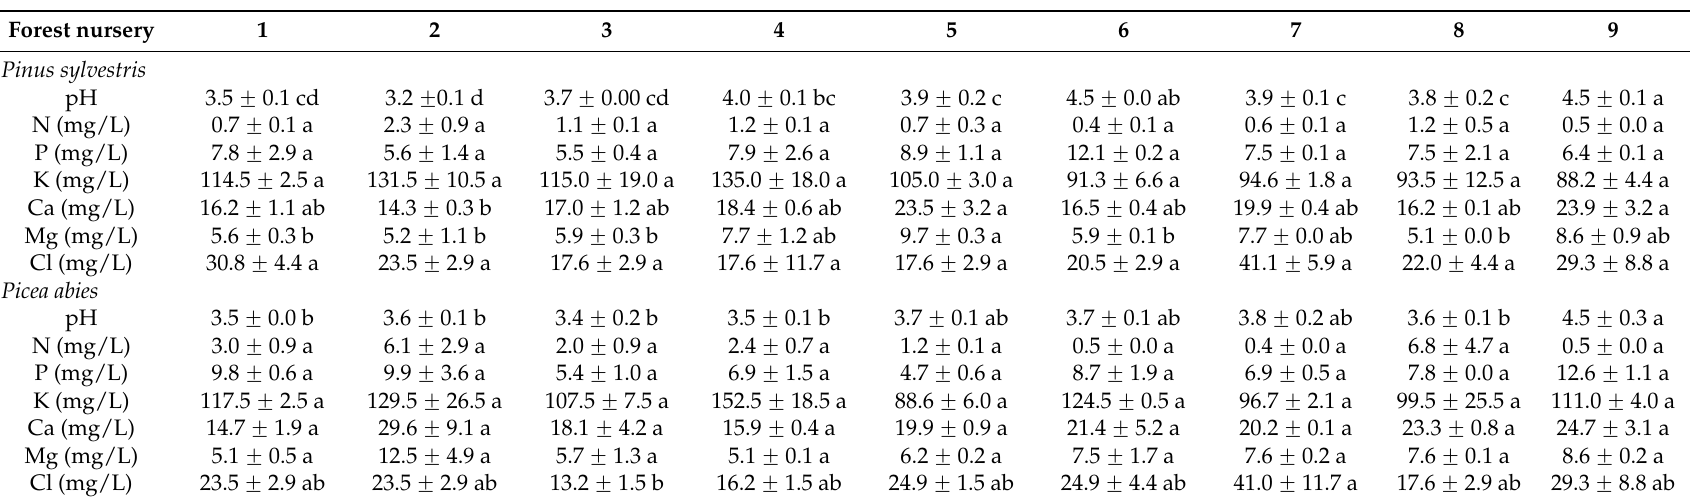
Table 3. Chemical characteristics of the sphagnum peat growth substrate of Pinus sylvestris and Picea abies seedlings from nine forest nurseries in Sweden. Values show the mean value ˘ standard error. Forest nurseries are numbered as in Table